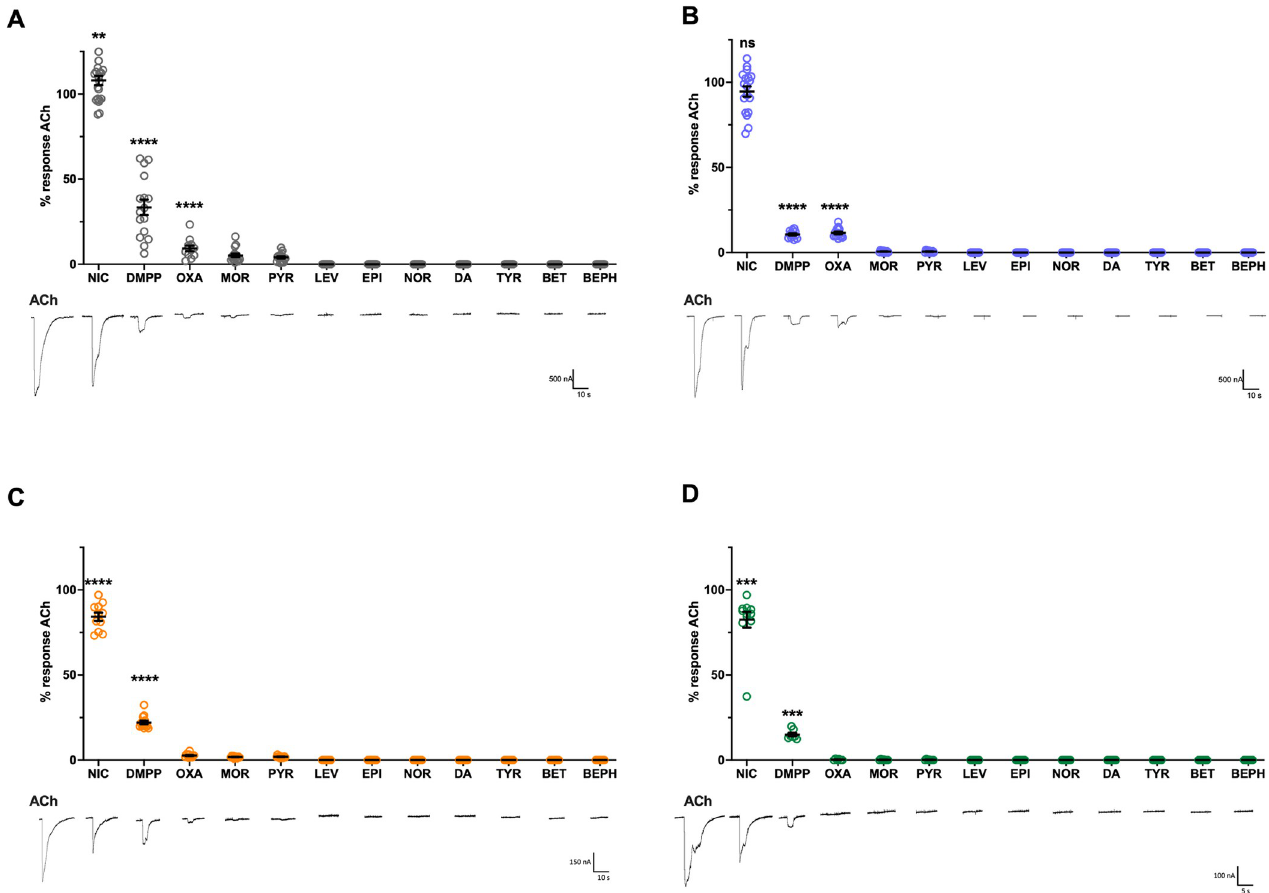
Fig 5. No change in ligand response profile is observed in clade III N-AChRs. N-AChR responses to different pLGIC agonists were measured to determine if declining maximal response is due to changing ligand preference. Current responses to 100 μ M for all ligands are shown normalized to 100 μ M acetylcholine for (A) A . suum , (B) D . medinensis , (C) G . pulchrum , (D) T . callipaeda . All four receptors had similar response profiles: ACh � NIC >> DMPP > OXA = MOR = PYR > LEV = EPI = NOR = DA = TYR = BET = BEPH. Circles represent responses from individual oocytes. Similar ligand response profile indicates no change in ligand occurs down clade III receptor phylogeny. �� p < 0.01; ��� p < 0.0005; ���� p < 0.0001. Error bars represent standard error. n > 6 for